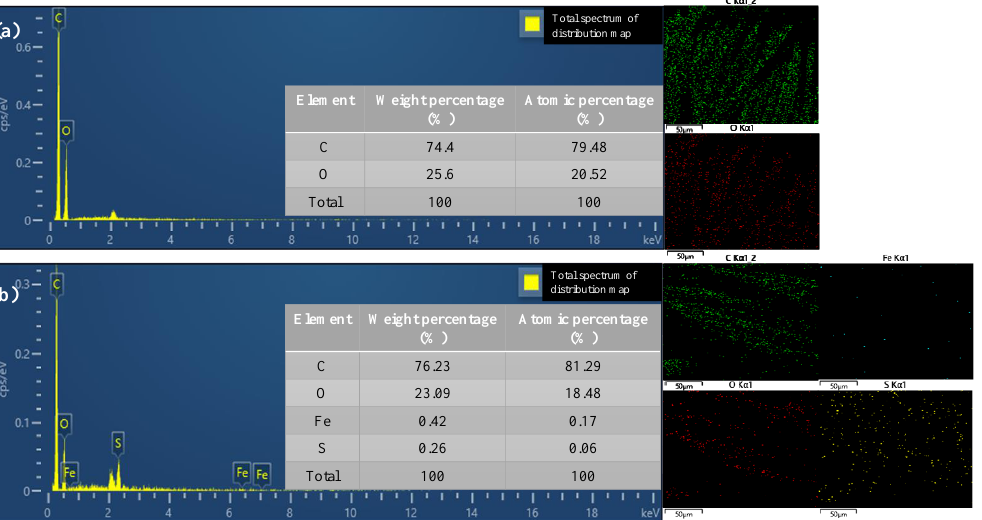
Figure 4. EDS spectra of ( a ) PET fabric and ( b ) CA-Fe-SH-PET fabric. In order to further determine the chemical structure and surface composition of CA- Fe-SH-PET, FTIR and XPS were tested. As shown in Figure 5a, the peaks at 1711 cm − 1 , 1242 cm − 1 , and 1092 cm − 1 of the PET fabric belonged to the stretching vibration of C=O, C–O (ester) and − CH 2 , respectively. The wide absorption band at 3300 cm − 1 was assigned